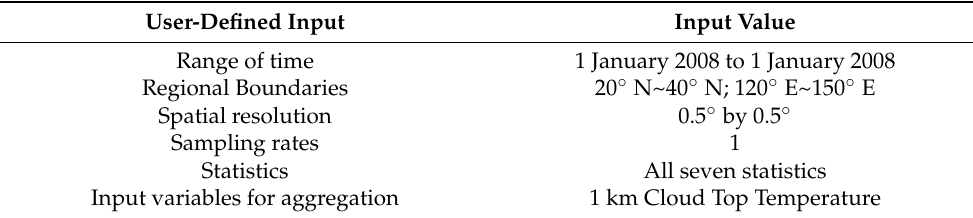
Table 4. The inputs defined for the 15-day averaged cloud top temperature over the North-East Pacific